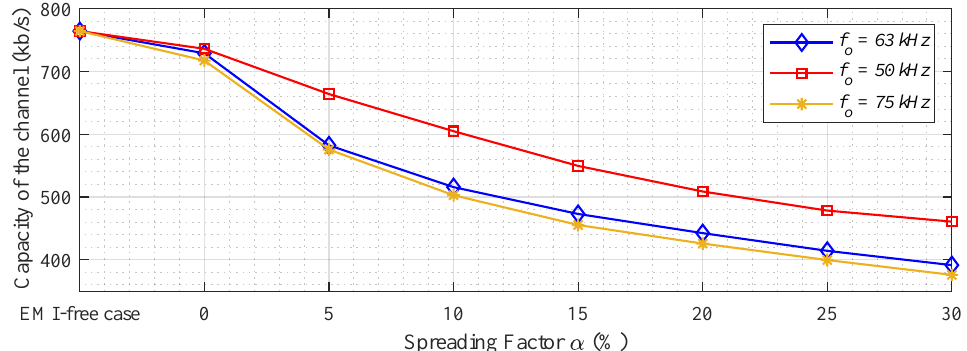
Figure 12. The PLC channel capacity in the case of several values of spreading factor with the change in the central switching frequency of